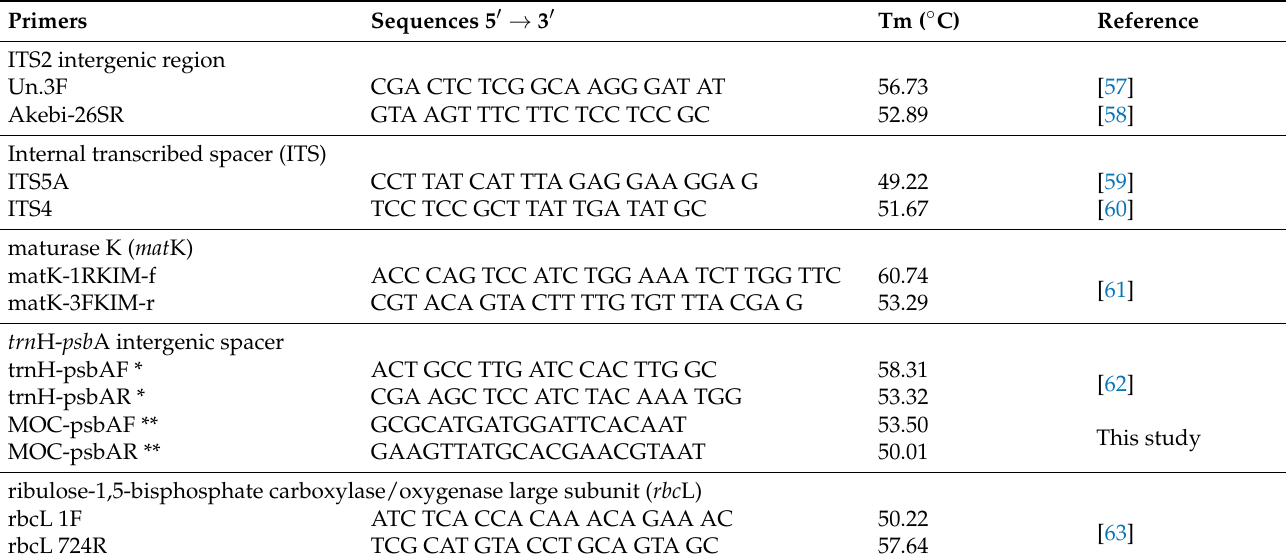
Table 5. Lists of Primers used in this